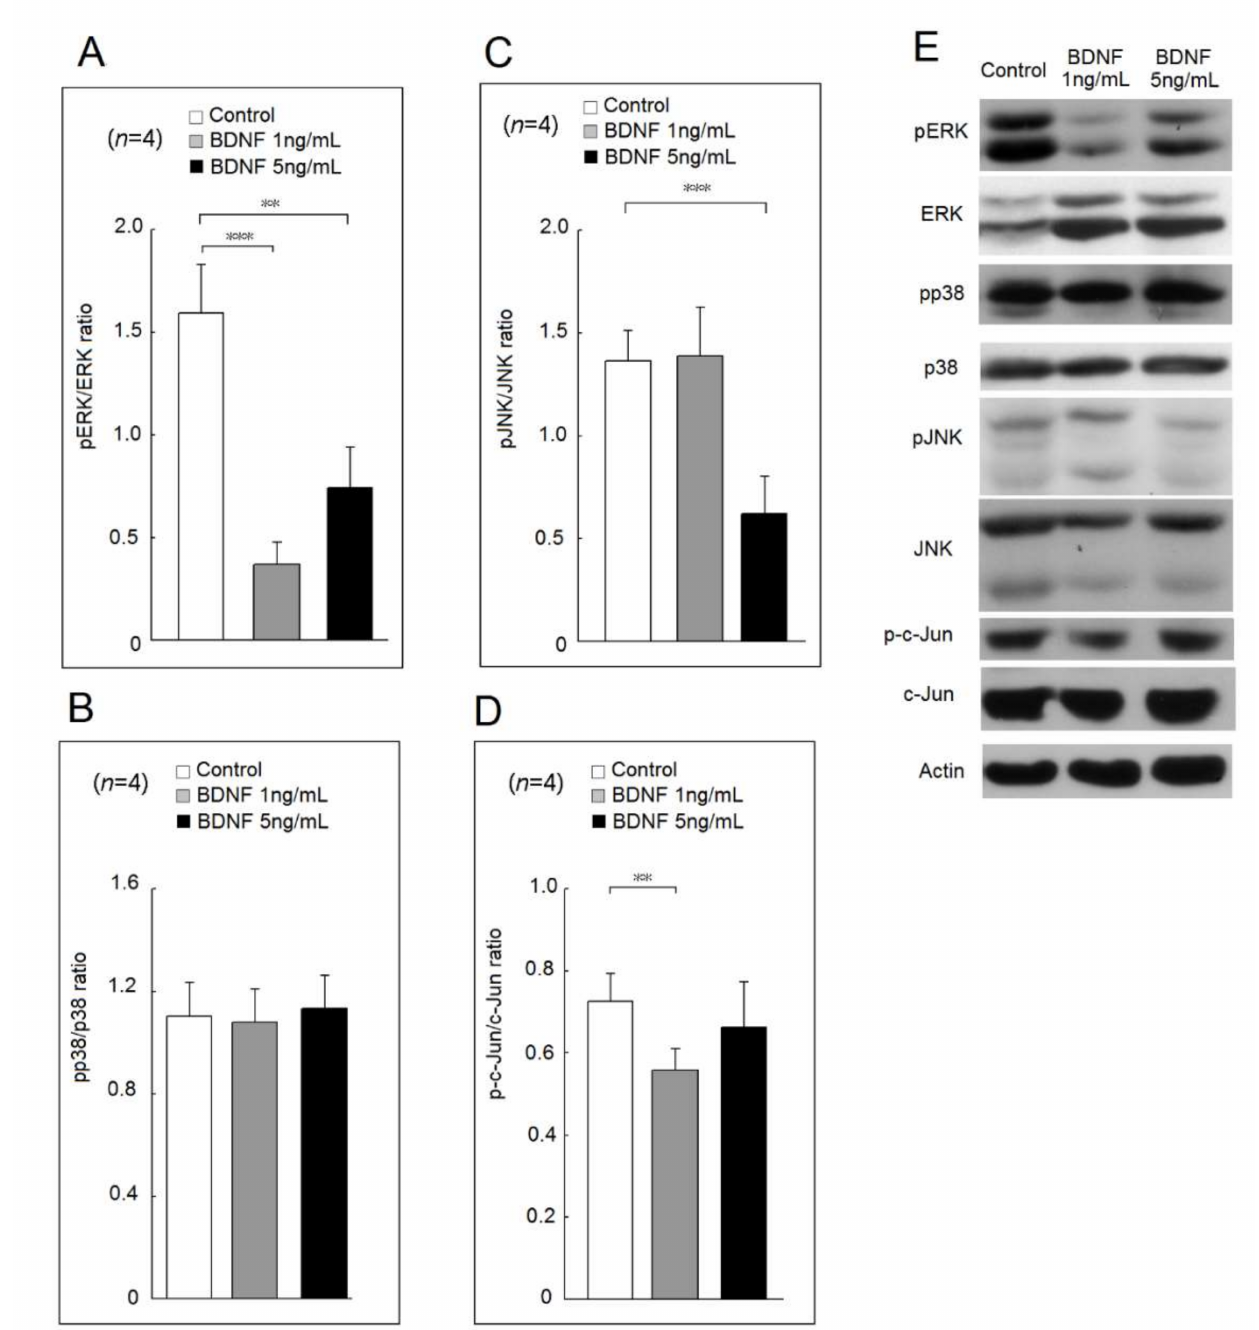
Figure 2. Effects of BDNF at concentrations of 1 ng/mL and 5 ng/mL in mitogen-activated protein kinase (MAPK) and c-Jun phosphorylation of U937 cells. The phosphorylation ratio of ( A ) extra- cellular signal-regulated kinases (ERK), ( B ) p38, ( C ) c-Jun N-terminal kinases (JNK) and ( D ) c-Jun in U937 cells after cultured with medium only, low concentration of BDNF (20 ng/mL) or high concentration of BDNF (200 ng/mL) for 48 h. ( E ) A representative case (** p < 0.01; *** p <